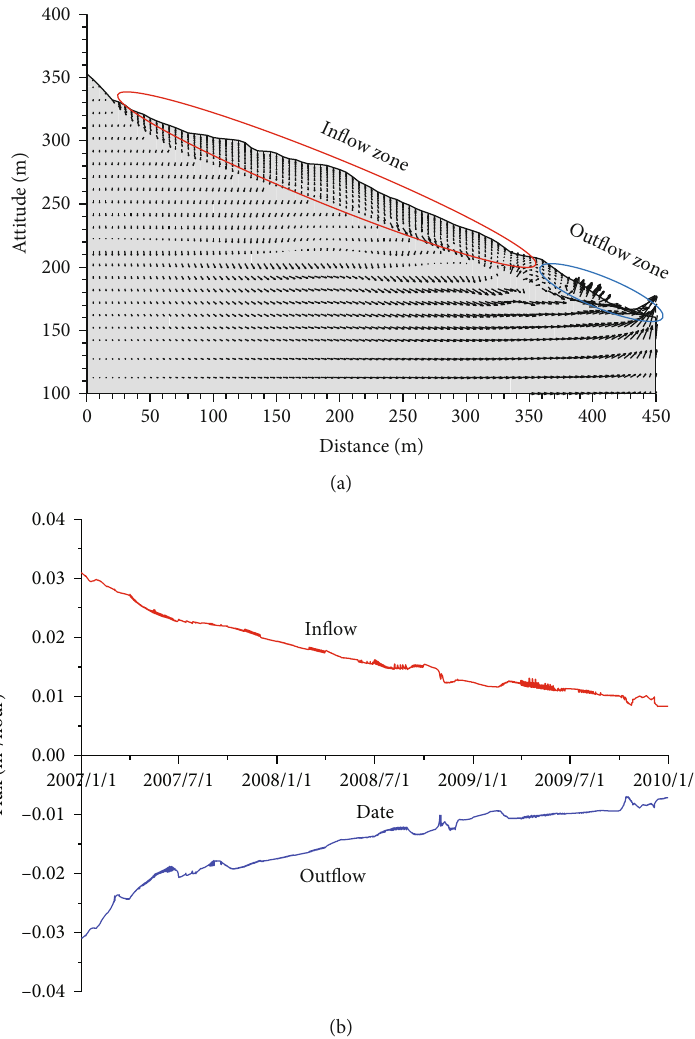
Figure 7: (a) In fl ow zone and out fl ow zone at a speci fi c time (Feb 2008). (b) In fl ow and out fl ow rainwater fl ux versus